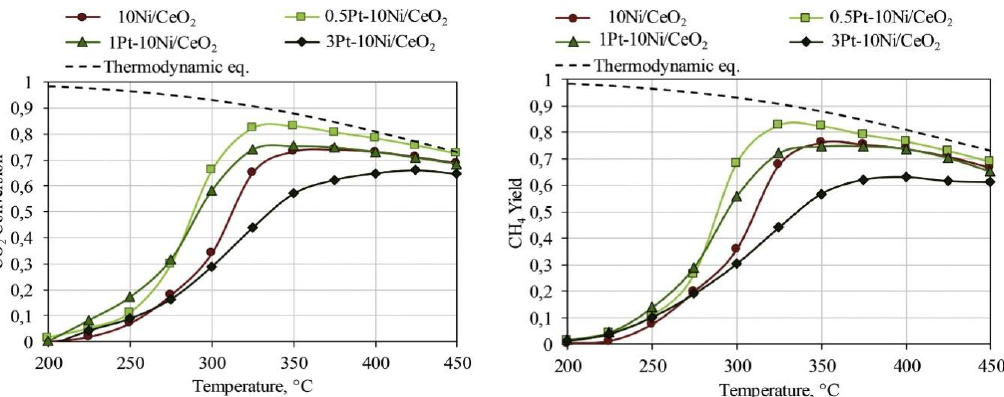
Figure 13. CO 2 conversion and CH 4 yield trends for the samples doped with 0.5%, 1% and 3% of platinum (H 2 :Ar:CO 2 = 4:5:1; WHSV = 60 L/(h·g cat )). Reproduced with permission from [33]. Copyright: Elsevier, Amsterdam, The Netherlands, 2020.